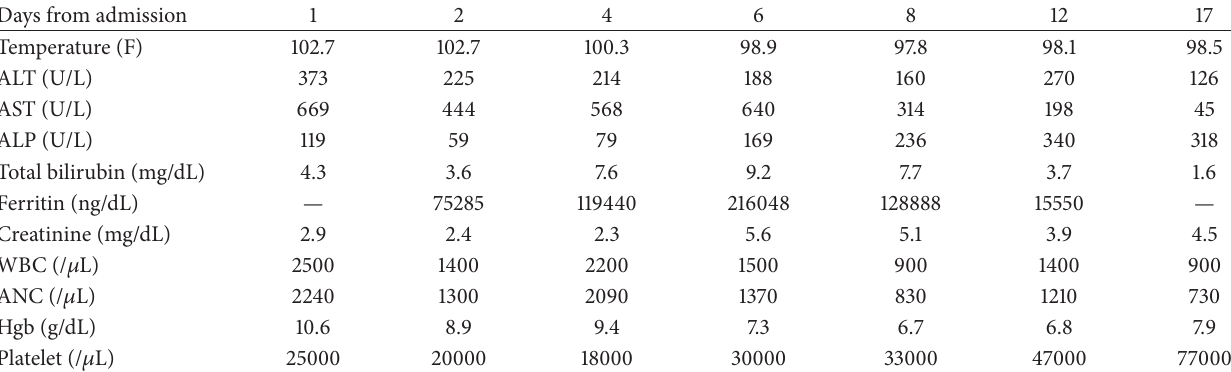
Table 1: Trend of liver function test, ferritin levels, blood counts, and creatinine during the initial hospital